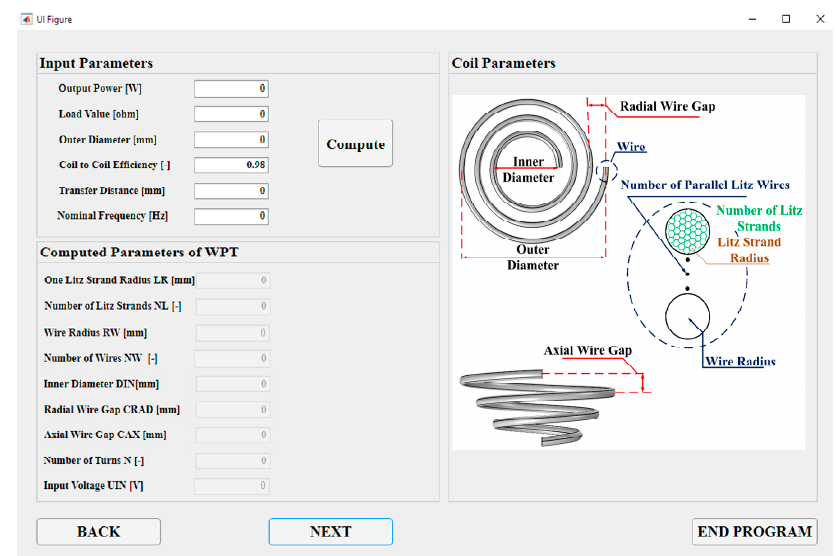
Figure 12. Display showing input parameters definition regarding application purposes (top—left part) and display showing calculated parameters of the coil (bottom—left part).